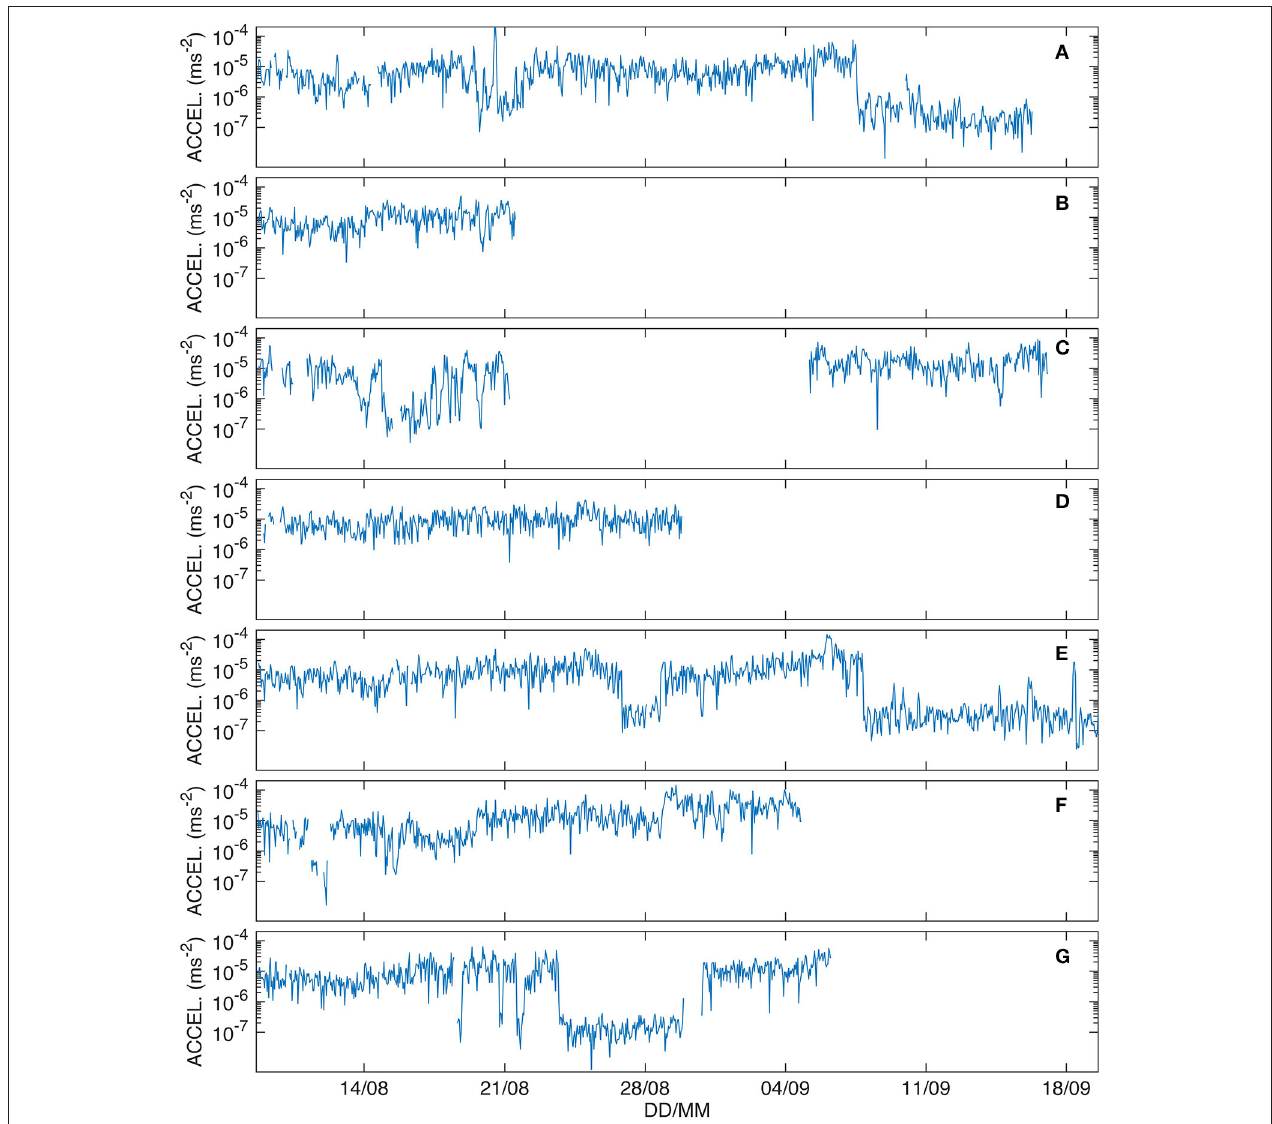
FIGURE 12 | Magnitude of acceleration for each EXITE beacon during August–September